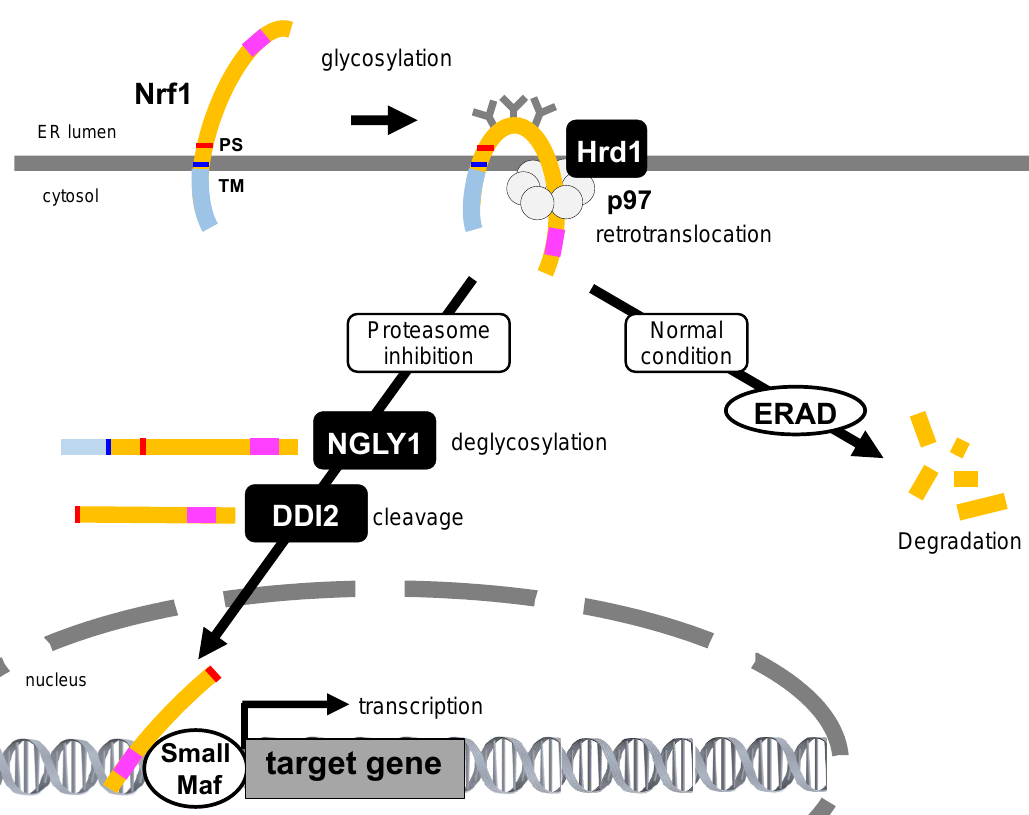
Figure 3. Nrf1 activation under the proteasome dysfunction. Under normal conditions, Nrf1 is ubiquitinated, retrotranslocated, and degraded by the ER-resident E3 Hrd1, p97, and proteasome, respectively. During proteasome inhibition, Nrf1 is glycosylated in the ER, ubiquitinated by Hrd1, and then retrotranslocated by p97. In the cytosol, polysaccharides attached to Nrf1 are removed by NGLY1 to generate the full-length Nrf1. Then, aspartic protease DNA damage-inducible 1 homolog 2 (DDI2) cleaves Nrf1 at the N-terminus region and produces the processed Nrf1. The processed Nrf1 translocates from the ER into the nucleus and promotes the expression of targets including proteasome subunit genes. Transcription activation domain is represented as a pink square. TM: transmembrane, PS: processing site.